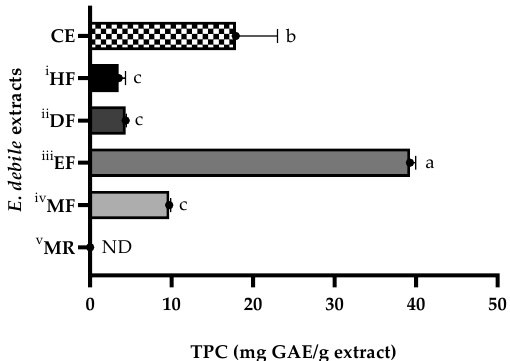
Figure 5. Total phenolic contents (TPC) of E. debile extracts. i – v Successive partition of crude extract (CE) (10.45 ± 1.20 g) into hexane fraction (HF), dichloromethane fraction (DF), ethyl acetate fraction (EF), methanol fraction (MF), and methanol insoluble residue (MR). All data are presented as mean ± SD of triplicates. Total phenolic contents were expressed as GAE (gallic acid equivalents). ND indicates not detected. Letters (a, b, and c) indicate significant differences of means between the groups based on Tukey’s HSD one -way ANOVA ( p -value < 0.05).